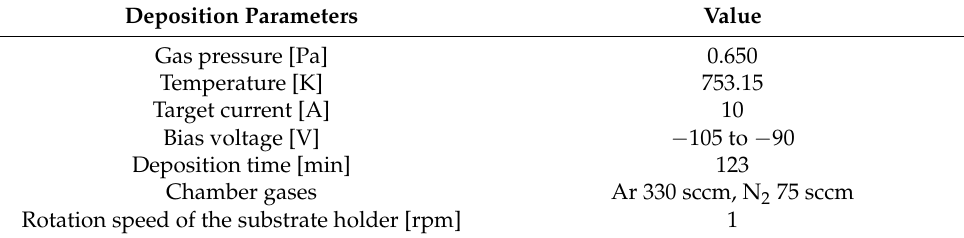
Table 1. PVD deposition